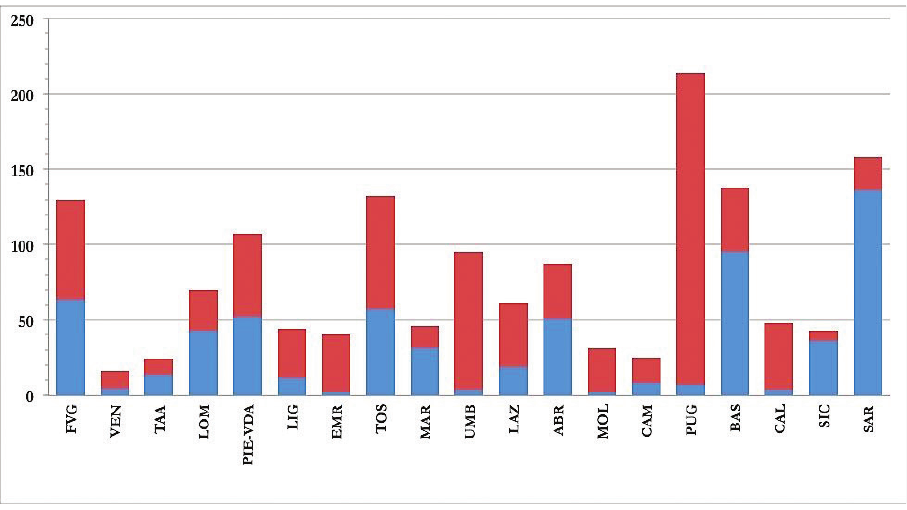
Figure 7. Number of wild species used in Italian regions: in blue the taxa in Guarrera (2006b) are shown; red bars show data from the present work, based on several recent analyses of Italian Regions